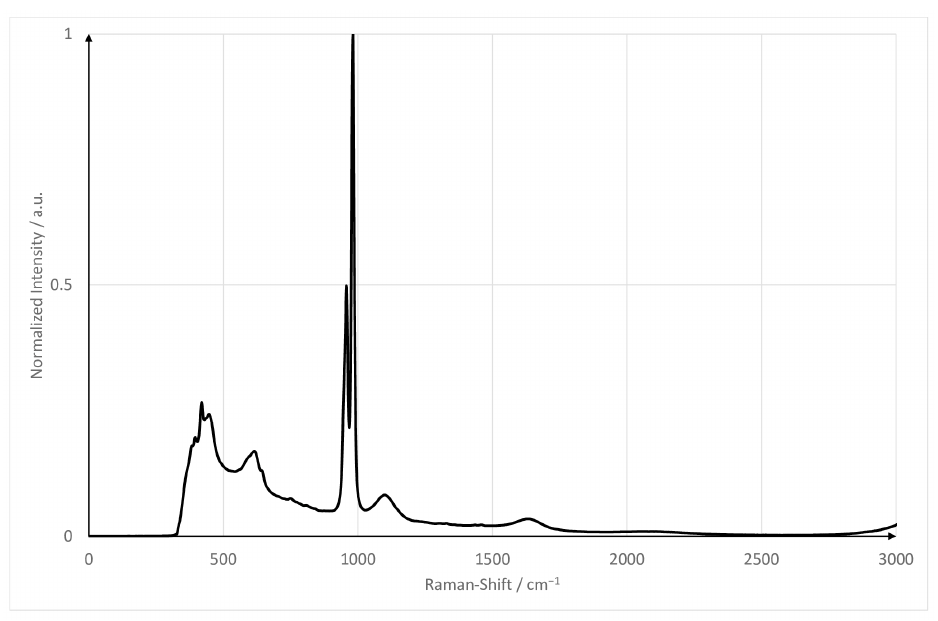
Table 2. Optical components.